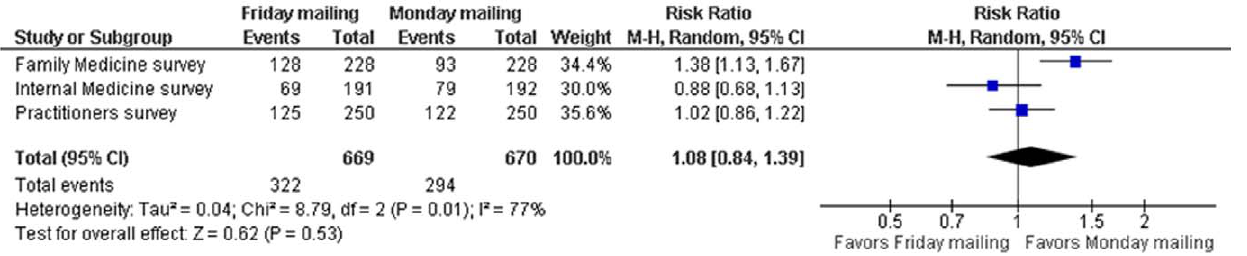
Figure 5. Meta-analysis of response by the time of second reminder comparing Friday vs. Monday mailing.